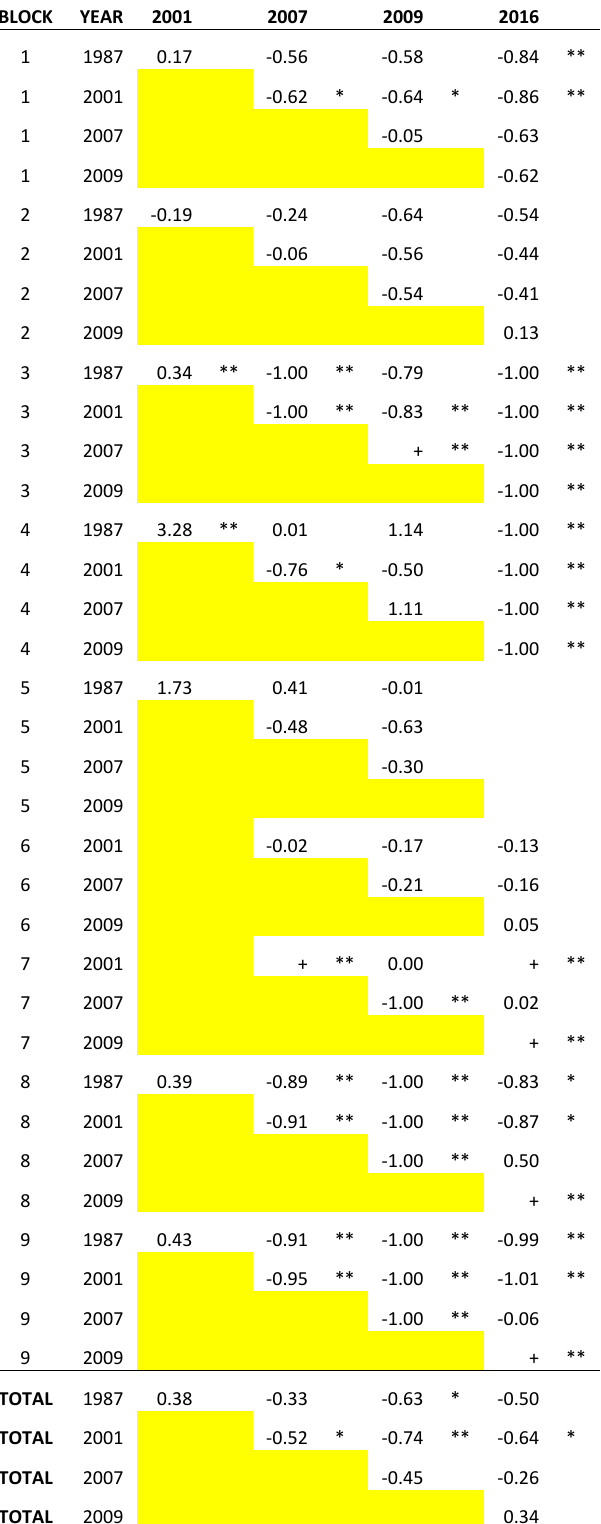
Table 3. Comparison of corrected abundance estimates of common minke whales for all strata and the entire survey area. Estimates for 1987 and 2001 are from Borchers et al. (2009). Cells list proportional change from first year to second. Plus or minus sign indicates change to or from abundance of zero. * = P <0.05, ** = P